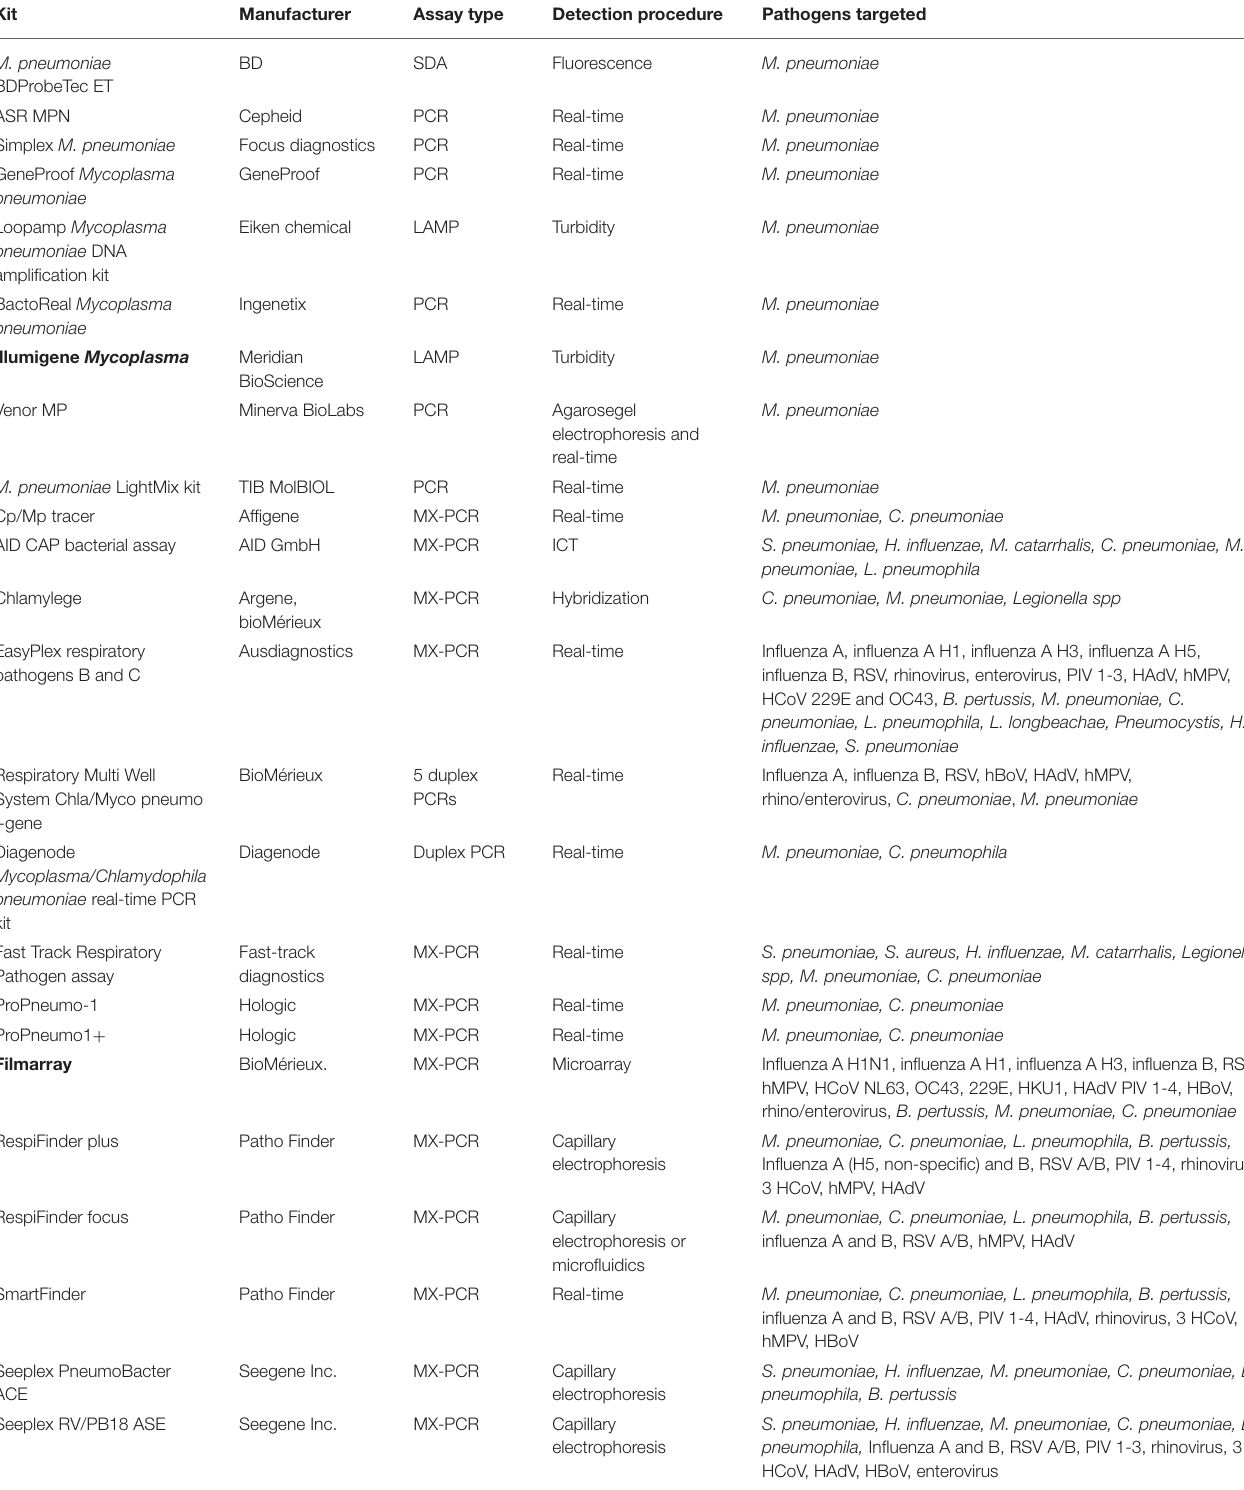
TABLE 1 | Summary of commercially available single and multiplex PCR assays for detection of M. pneumonia